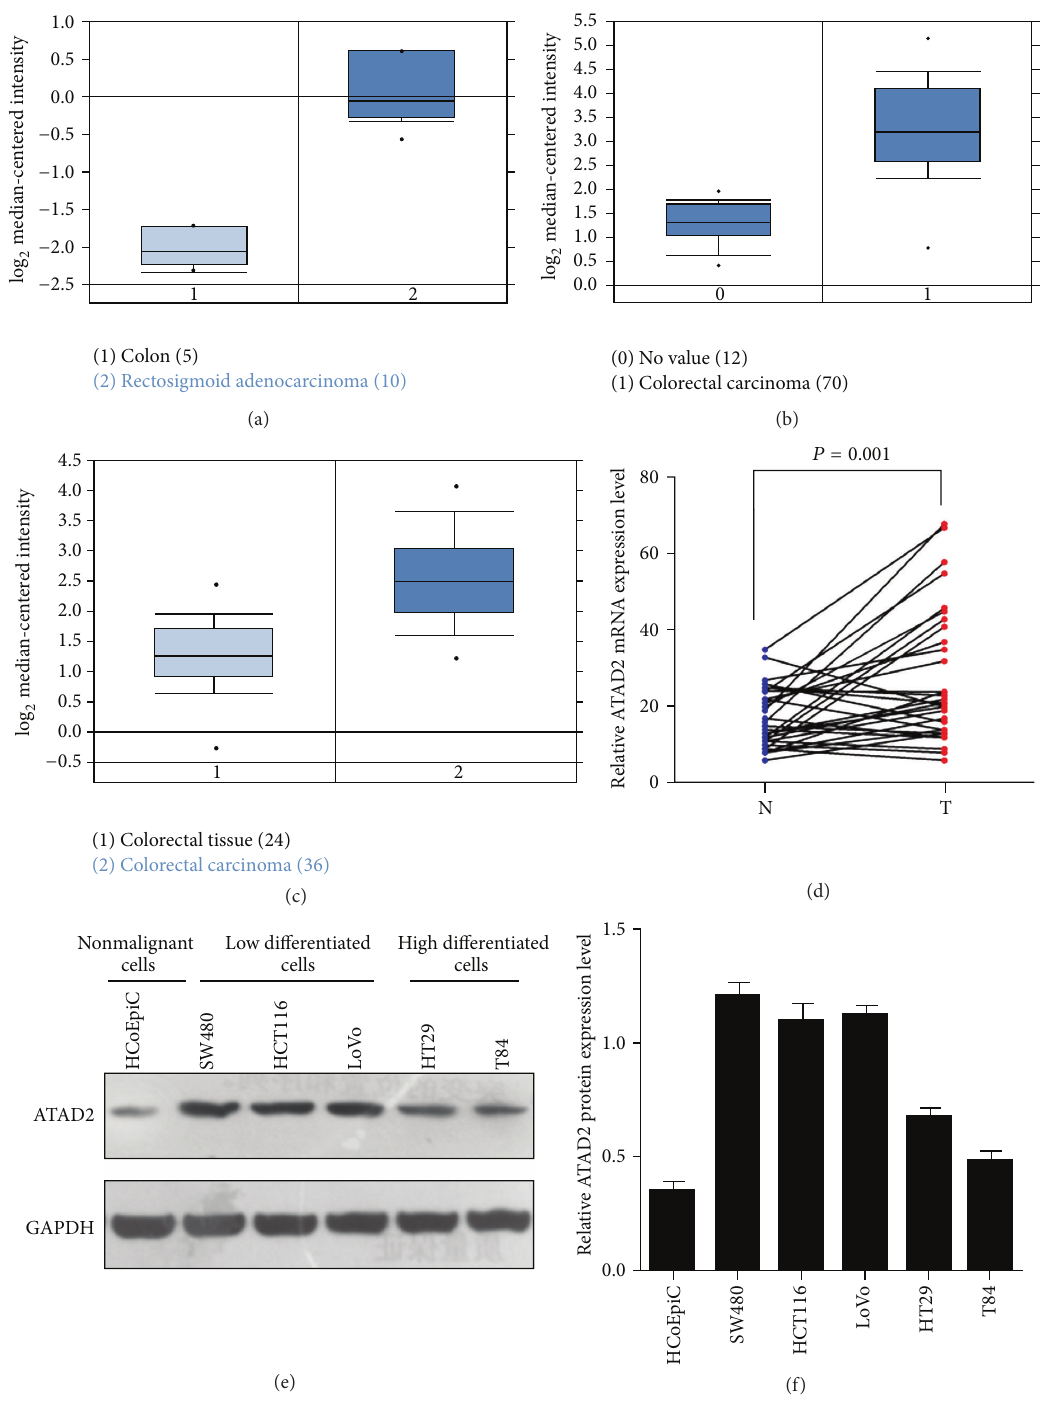
Figure 1: ATAD2 expression in CRC at mRNA and protein level. (a)–(c) ATAD2 expression in Kaiser Colon (a), Hong Colorectal, (b) and SkrzypczakColorectal(c).(d)IncreasedATAD2mRNAexpressionin32matchedtumor(T)andnontumortissues(N)wasdetectedbyqPCR. (e)-(f) Western blots show the ATAD2 expression in five CRC cell lines and the nonmalignant HCoEpiC cells. 𝑃 values were calculated by paired 𝑡